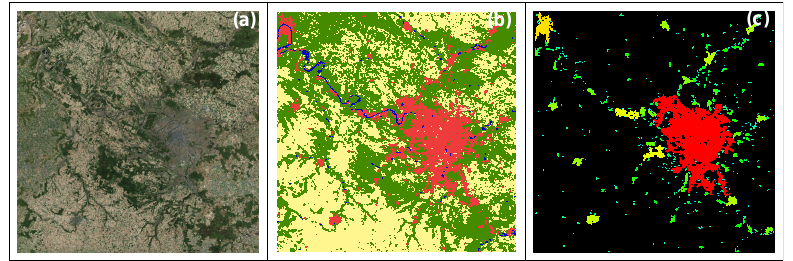
Figure 1. Application of city clustering to urban land cover data. The following panels illustrate different aspects of the city of Paris and its surroundings: ( a ) Remote sensing image as extracted from the ArcGIS 10 component ArcMap; ( b ) Urban land cover data as obtained from the GlobCover 2009 land cover map. The colors indicate urban (red, class 190), water bodies (blue, class 210), forests and grasslands (green, classes 20-110), and rainfed croplands (yellow, class 14); ( c ) From the urban land cover and by taking l = 4km, the identified clusters are color coded according to the logarithm of their size: from small (light blue) via medium (green) to large (red). The cutout has the approximate area of (215km) 2 .